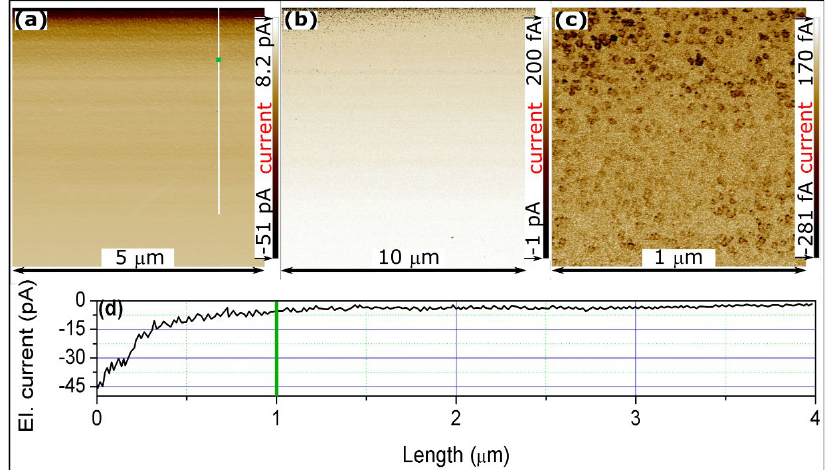
Figure 5. The maps of local current obtained by C-AFM for samples NiTi (forces 100 nN, sample bias −8 V) ( a ), Alu10 (forces 100 nN, sample bias −4 V) ( b ) and Pt100 (the maximum interaction force was 5 nN, sample bias −5 V, measured simultaneously with topography (Figure 4c)) ( c ). The white line in subfigure ( a ) indicates positions of the cross section analysis ( d ).